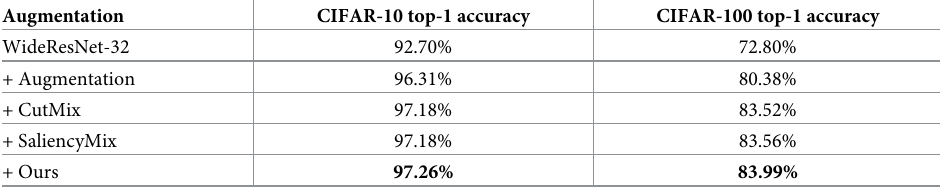
Table 2. Classification performance of the Wide ResNet-32 architectures on the CIFAR-10 and CIFAR-100 datasets.